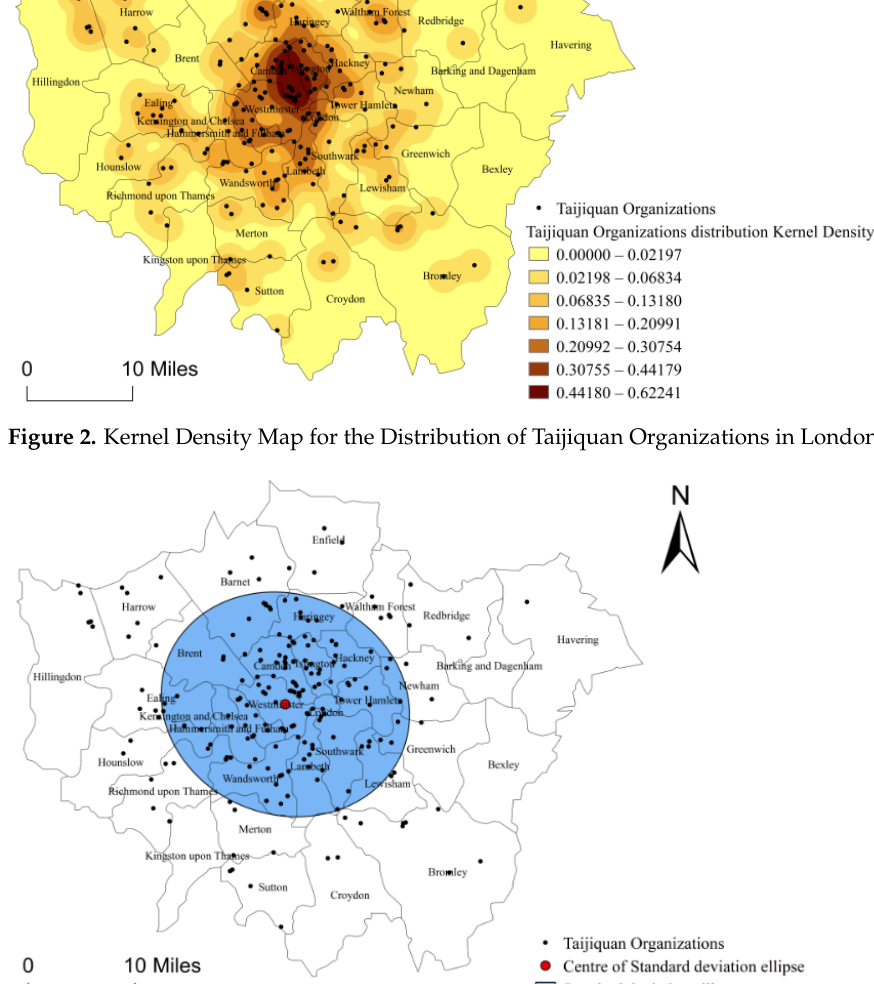
Figure 2. Kernel Density Map for the Distribution of Taijiquan Organizations in London.